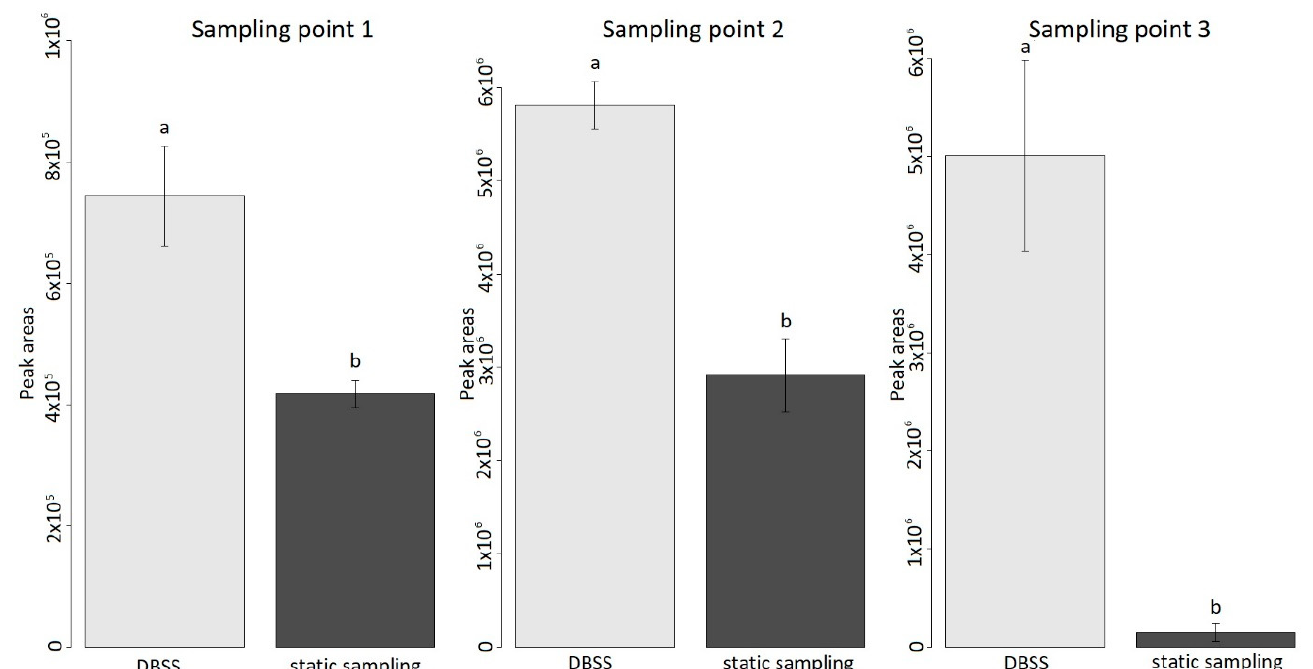
Figure 5. The amount of total MTs collected using DBSS (light grey) and static technique (dark grey) at sampling point 1, sampling point 2 and sampling point 3. Data are means ± standard deviation ( n = 3). Data were analyzed by one-way ANOVA test, and the letters indicate statistical differences between the two sampling techniques in each sampling point obtained from a Tukey post hoc test ( p ≤ 0.05). Results of statistical analysis are reported in Table S4.